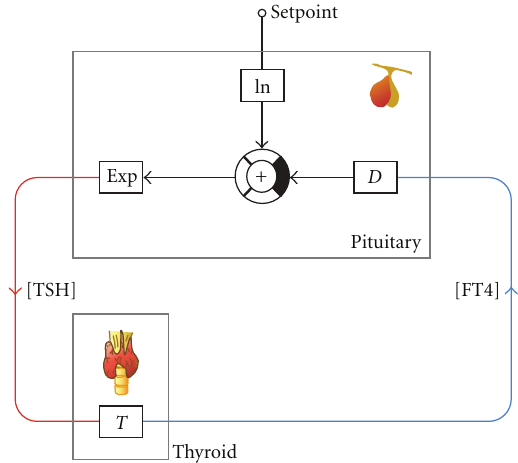
Figure 1: Information processing structure of the logarithmic standard model of thyroid homeostasis [105,